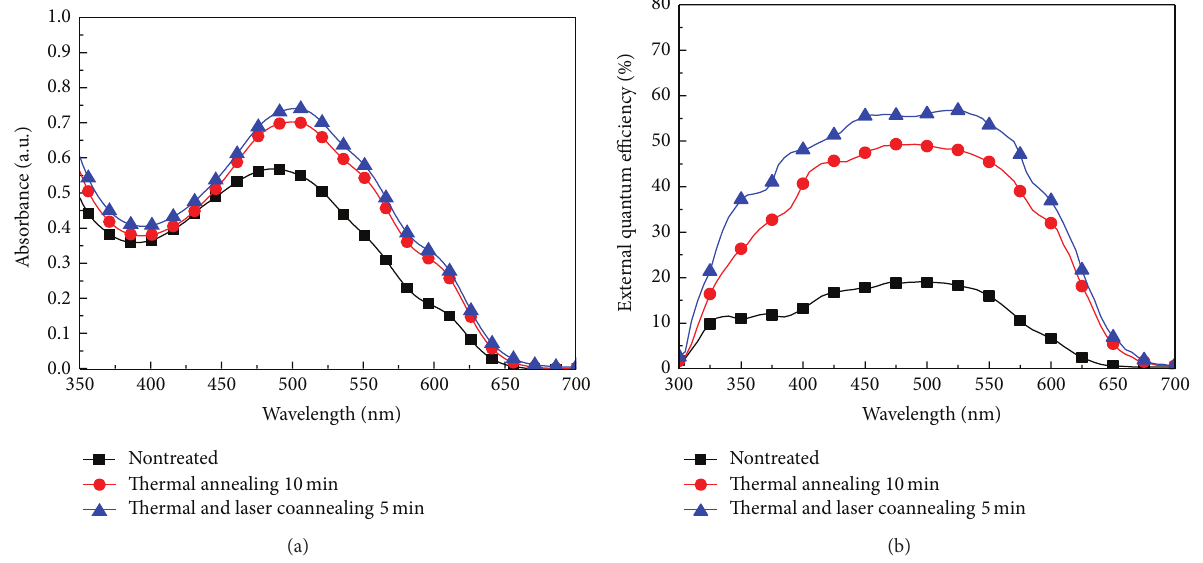
Figure 3: The (a) UV-vis absorption spectrum of P3HT:PCBM films and (b) the external quantum efficiency of the devices under different annealing process.